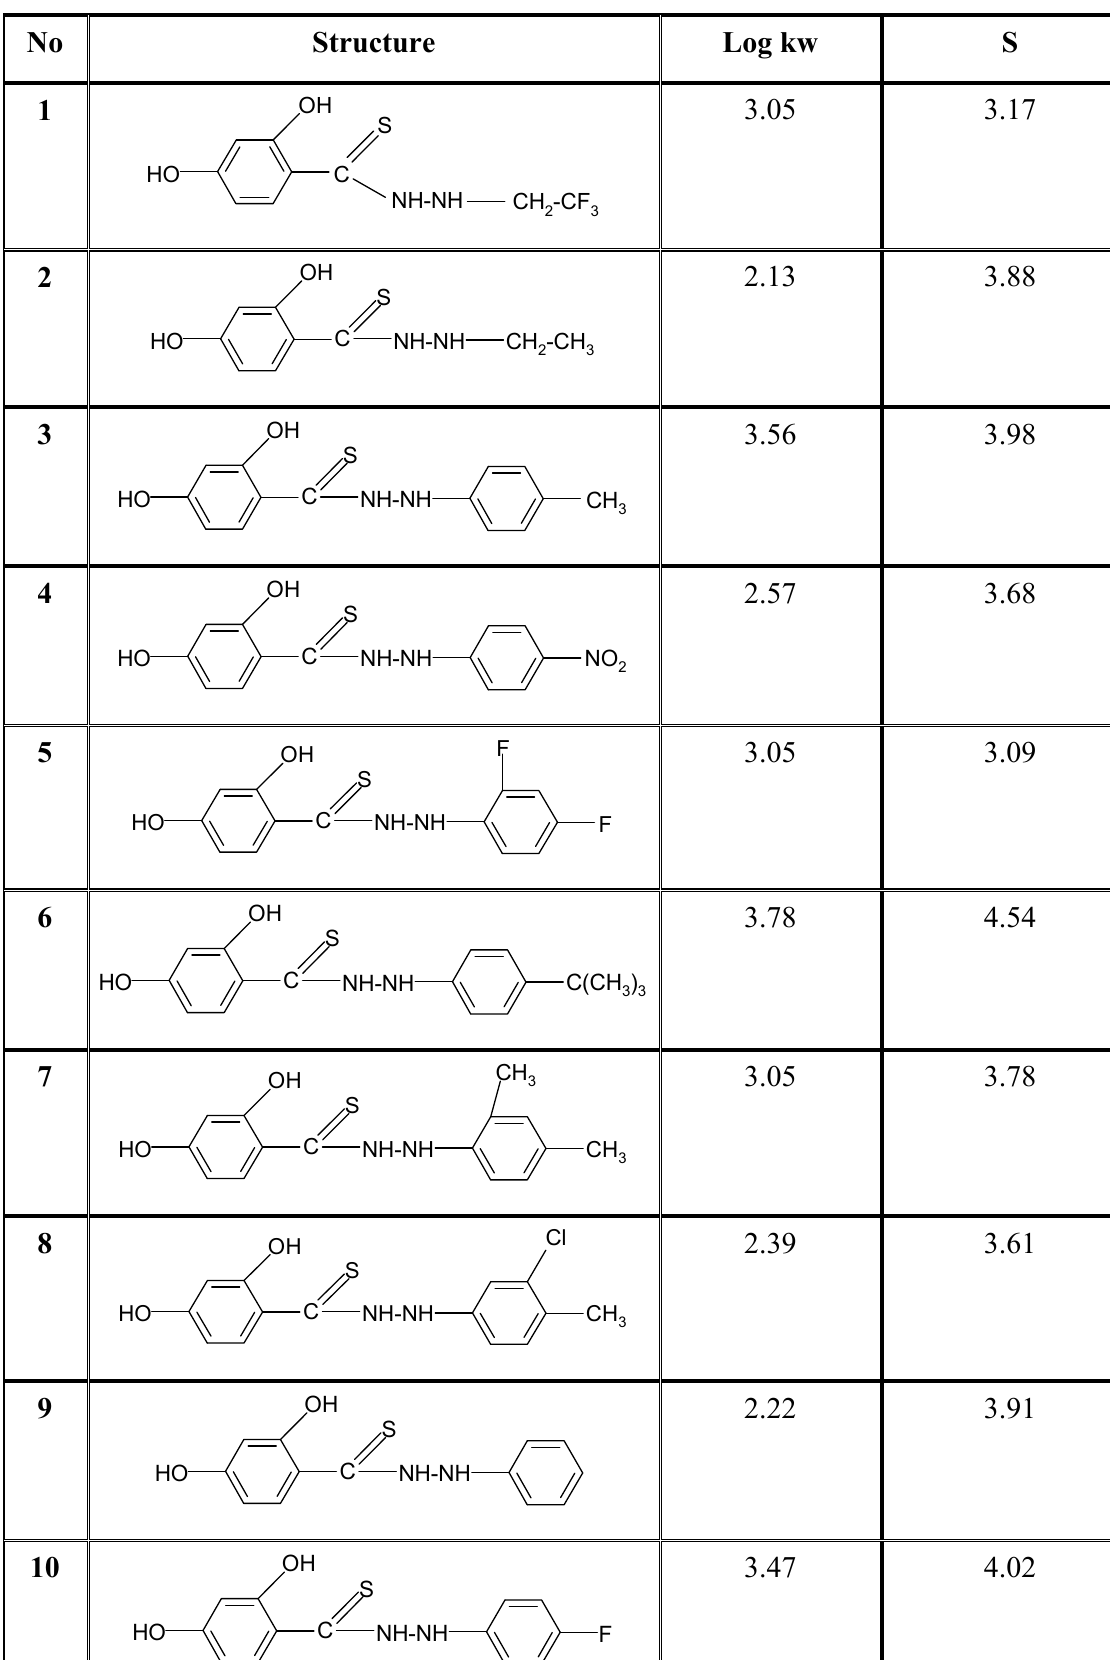
Table 2. Structure of prepared